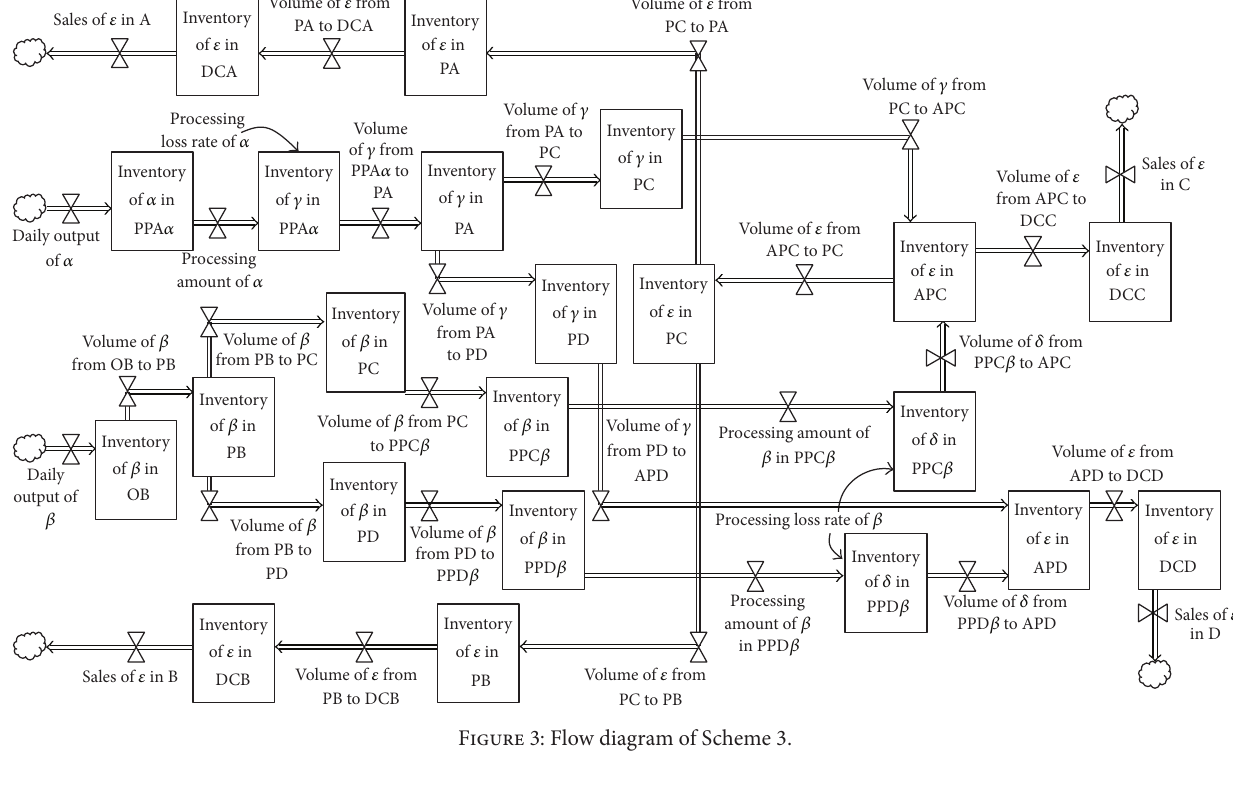
Figure 3: Flow diagram of Scheme 3 .